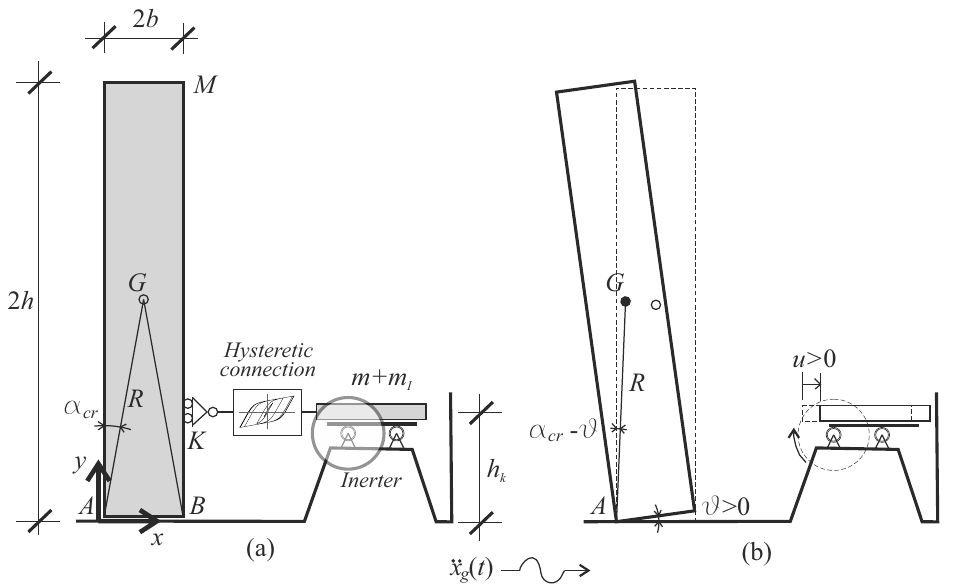
Figure 1. Coupled mechanical system: ( a ) geometrical characterization; ( b ) positive directions of the displacement u ( t ) and rocking angle θ ( t )